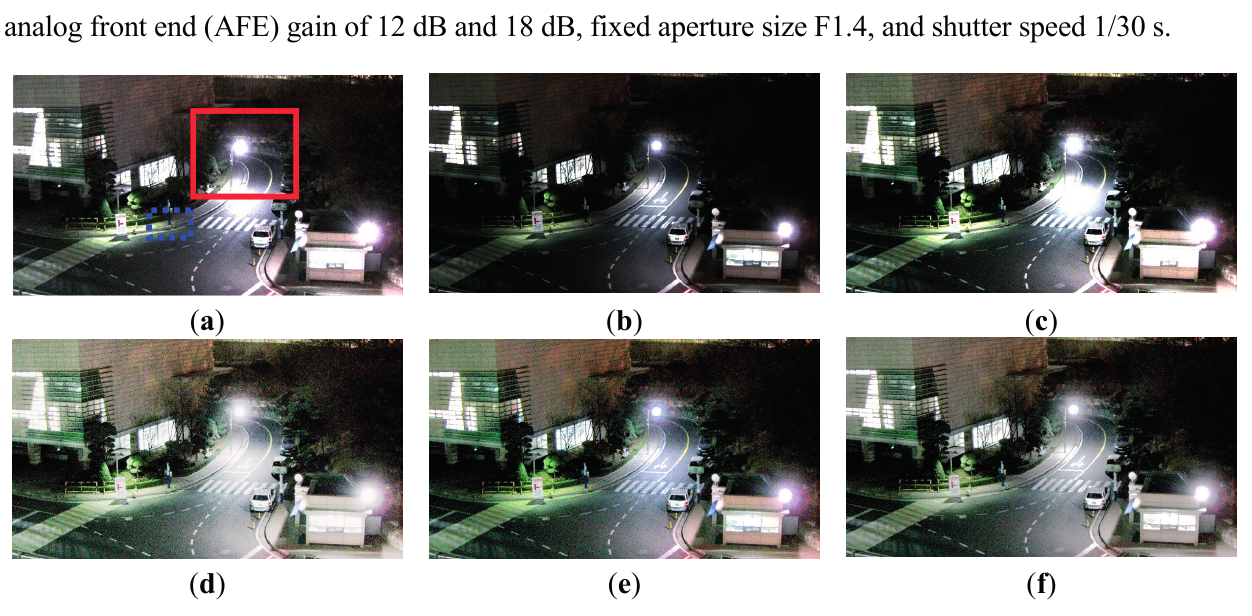
Figure 10. Experimental results using the outdoor image: ( a ) The reference image with 18 dB gain; ( b ) underexposed image with 12 dB gain; ( c ) enhanced image of (b) using ordinary two-pixel digital pixel binning; ( d ) enhanced image of (b) using Kim’s algorithm; ( e ) enhanced image of (b) using Jiang’s algorithm; and ( f ) enhanced image of (b) using the adaptive four-pixel digital pixel binning